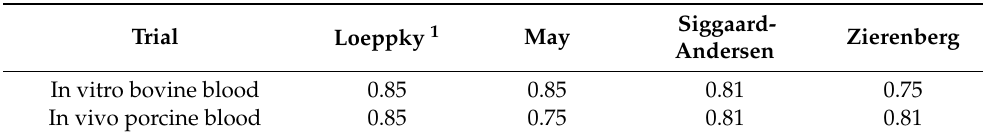
Table 1. Relative standard deviation of the prediction error ( ε ) of the four CO 2 solubility models in in vitro bovine and in vivo porcine blood trials.